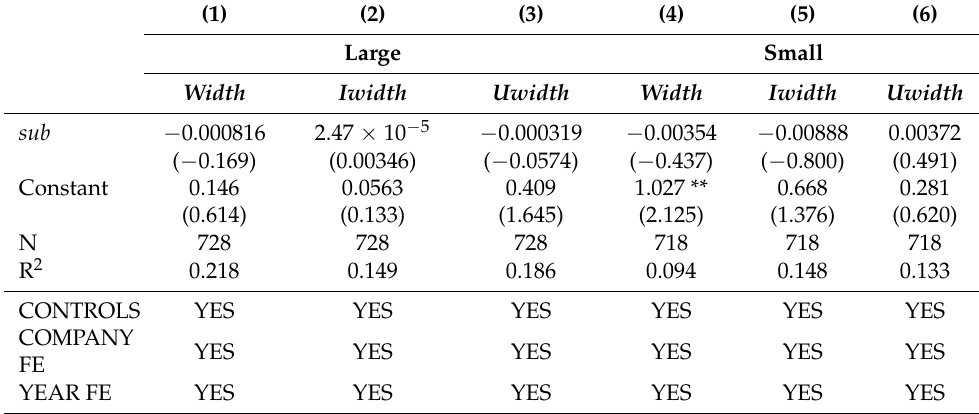
Table 15. Heterogeneity analysis: Enterprise size perspective (quality of technological